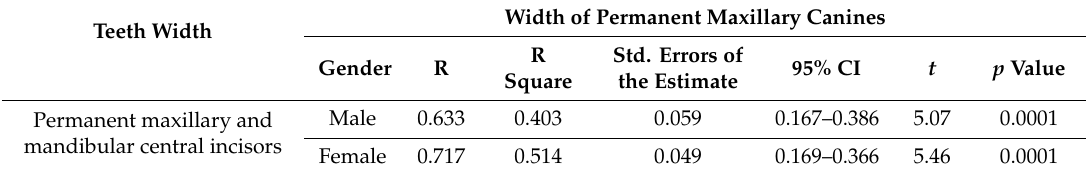
Table 3. Regression analysis for prediction of the sum width of permanent maxillary canines from the sum of widths of permanent maxillary and mandibular central